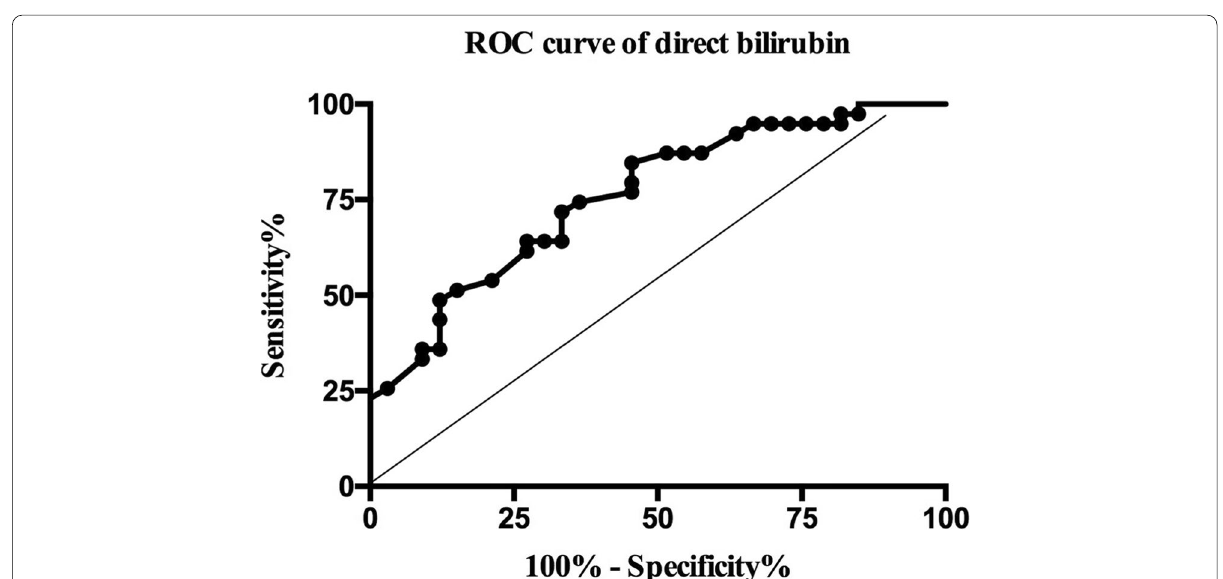
Fig. 3 The ROC curve of direct bilirubin to predict PJI. AUC 0.760 (95%CI: 0.651–0.870, P < 0.001), Cutoff = Specificity 54.45%, PPV 68.75%, NPV 75%, OR 6.60 (95%CI: = = = =